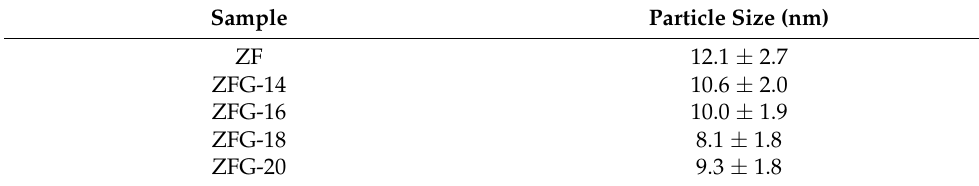
Figure 4. TEM image of ( a ) rGO, ( b ) ZF, ( c ) ZFG-14, ( d ) ZFG-16, ( e ) ZFG-18, and ( f ) ZFG-20. Table 2. Average particle size of ZF, ZFG-14, ZFG-16, ZFG-18, and ZFG-20.